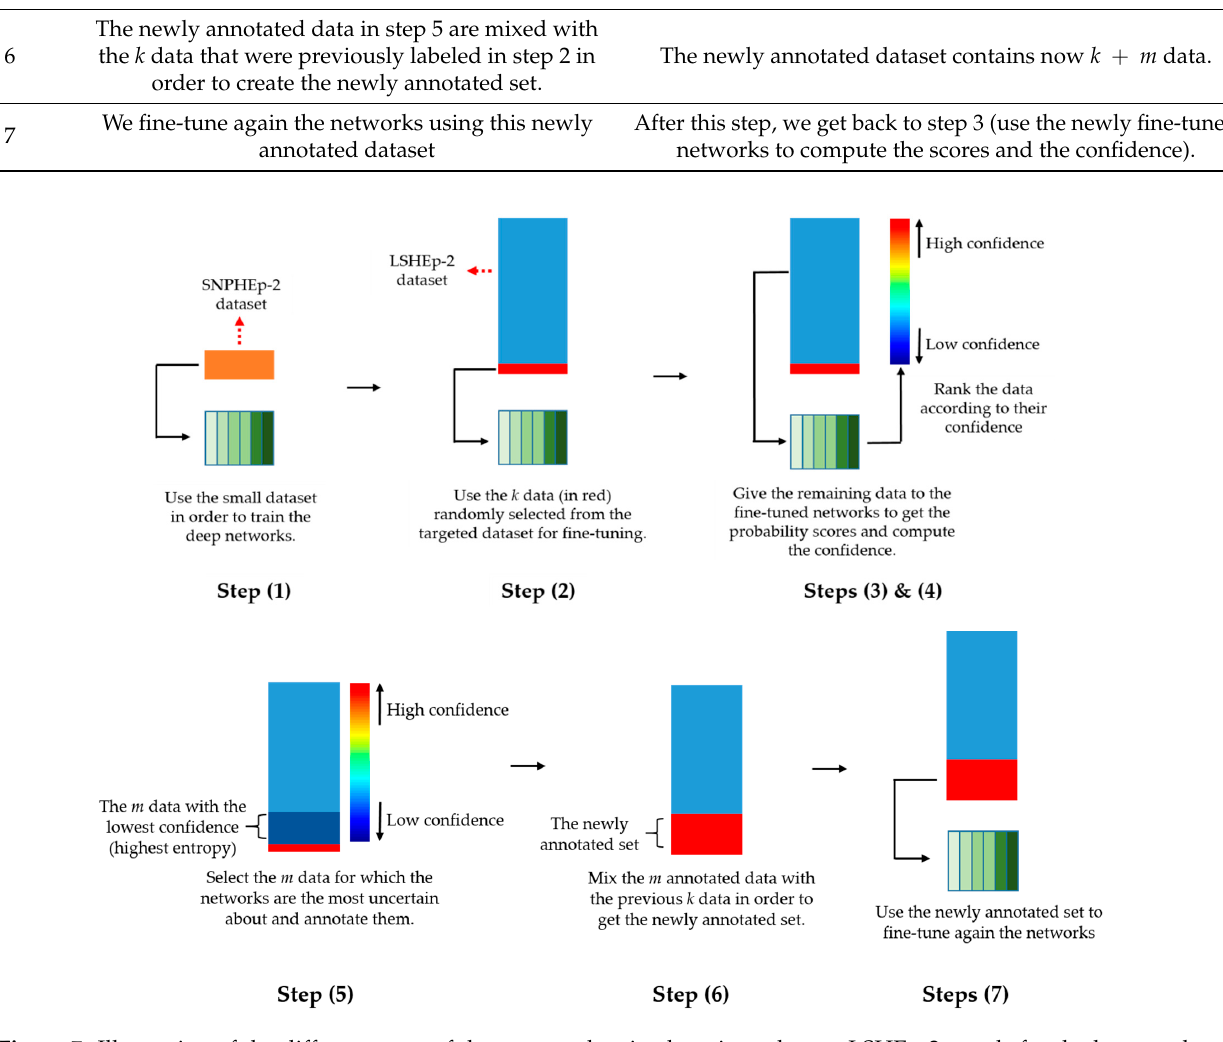
( e ) Figure 8. Example images from the SNPHEp-2 dataset. ( a ) The homogeneous, ( b ) the coarse speckled, ( c ) the fine speckled, ( d ) the nucleolar and ( e ) the centromere cells. The original size of the images is 112 × 112. Instead of using the ICPR2012 for the initial learning as done in [38], the choice of using the SNPHEp-2 dataset was justified by the similarities between this dataset and our targeted dataset. The targeted dataset is the large-scale HEp-2 (LSHEp-2) dataset, intro- duced by Qi et al. [60]. This dataset contains far more images (63,445) than the 13A dataset (13,596 images). The reason why we adopted the LSHEp-2 dataset is that we aimed to test the effectiveness of the proposed active learning scheme on a really big dataset for which labeling can really be burdensome. Furthermore, this dataset is more complex in terms of intraclass variations and heterogeneity compared to the others. The description of the LSHEp-2 dataset can be found in details in [60] and it can be downloaded at http://qixianbiao.github.io/HEp2Cell/. Similar to the 13A dataset, it contains six classes: homogeneous, speckled, nucleolar, centromere, nuclear membrane and Golgi cells. Some examples of this dataset are shown in Figure 9.